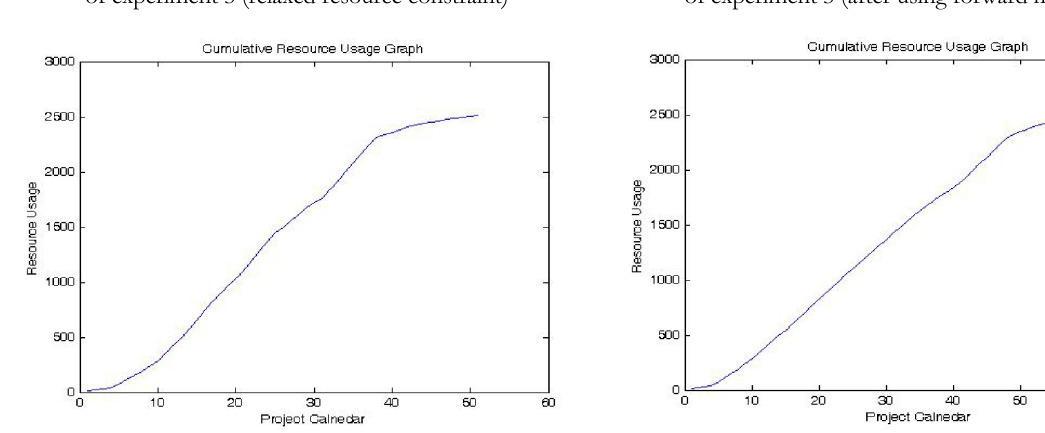
Figure 41. Cumulative resource usage for resource 1 of experiment 3 (after using forward method)